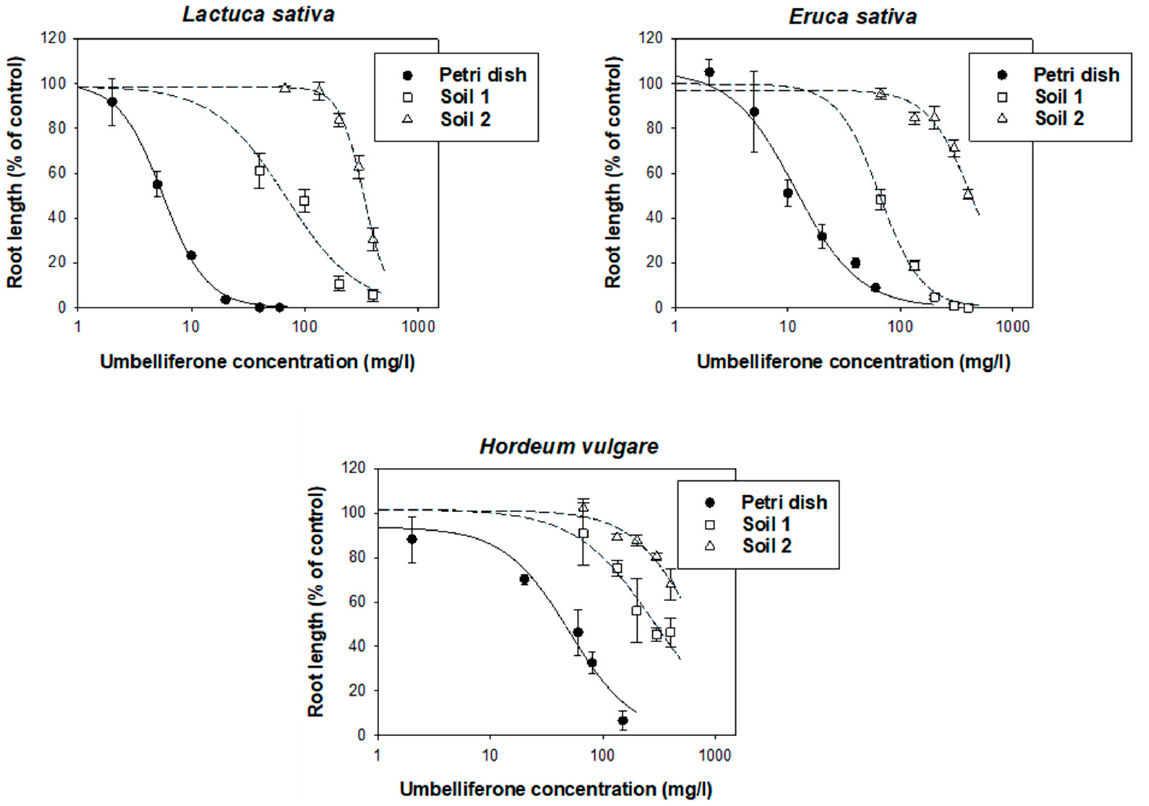
Figure 3. Dissipation data for umbelliferone applied at 40 and 4 mg/kg to the two soils selected for the study.